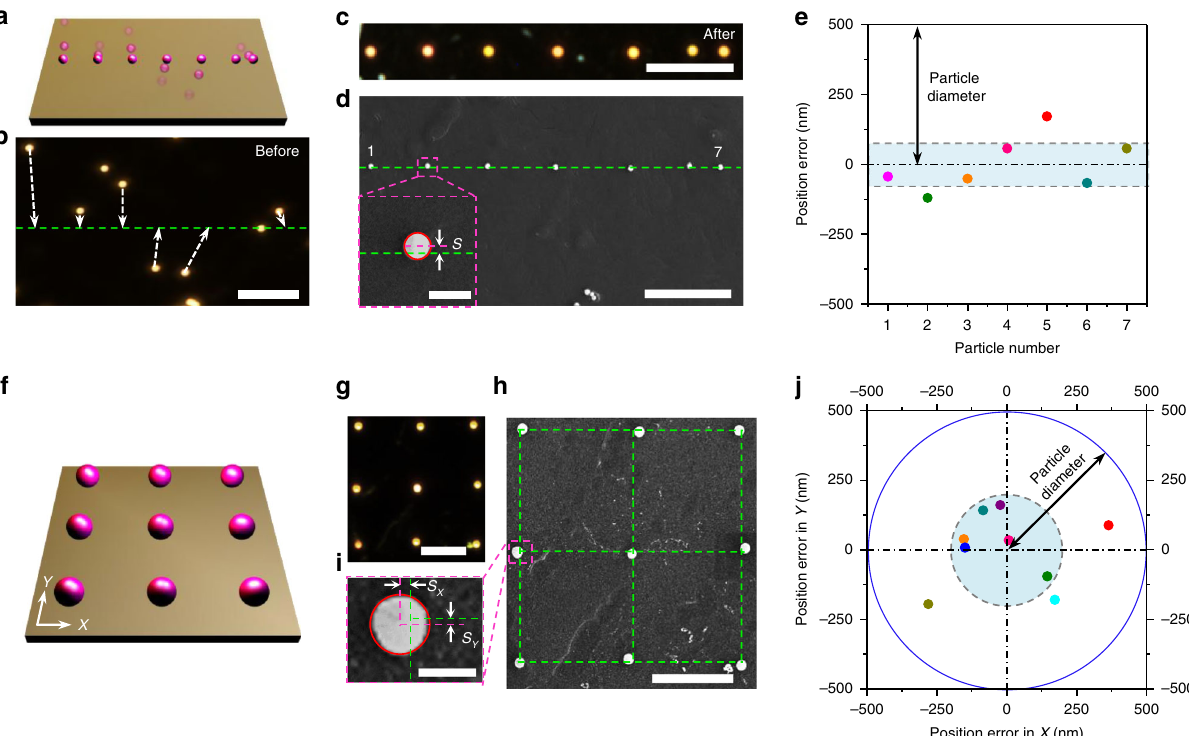
Fig. 3 Patterning accuracy of OPN. a Schematic illustration of the 1D assembly of seven 500nm SiNPs. b Dark- fi eld image of SiNPs before patterning. The white dashed arrows indicate the target positions of each SiNPs. c Optical image of SiNPs after 1D assembly. d SEM image of SiNPs after 1D assembly. The inset de fi nes the method to determine the position error S for individual SiNPs. e Position errors for each SiNPs in the line. The shaded area shows the average deviation from the target line, which is ~80nm. f , g Schematic illustration and dark- fi eld image of a 2D assembly of nine 500nm SiNPs into a 3×3 array. h SEM image of the 2D assembly. i The position error in X ( S X ) and Y ( S Y ) for individual SiNPs. j Position errors in X and Y for each SiNPs in the 2D array. The shaded area indicates the average deviation from the target positions, which is ~200nm. Scale bars: b – d 10 μ m; inset in d , 1 μ m; g , h , 5 μ m; i ,